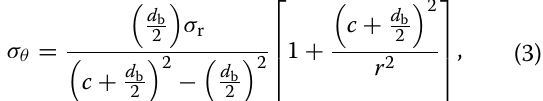
model based on non-linear regression analyses of bond